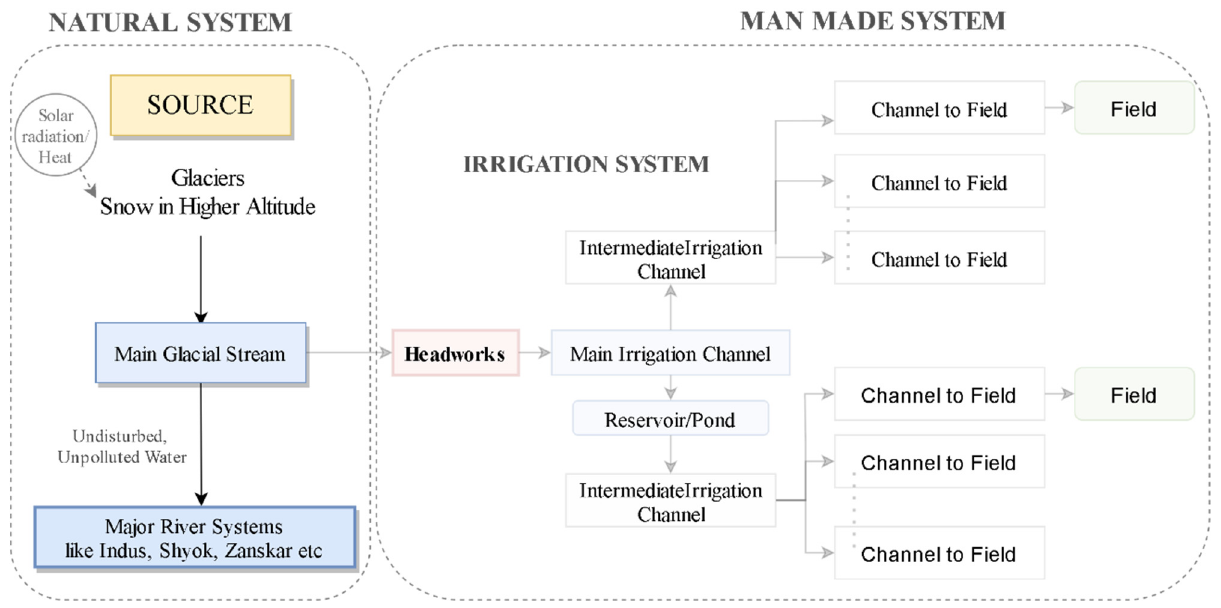
Figure 5. Traditional irrigation in the villages of Ladakh.